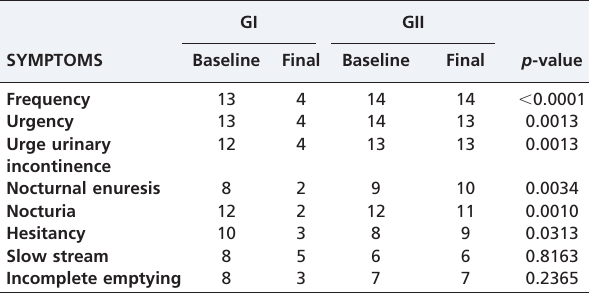
Table 2 - The number of patients complaining about storage and voiding symptoms before and after the intervention in the treatment (GI) and sham (GII) groups.